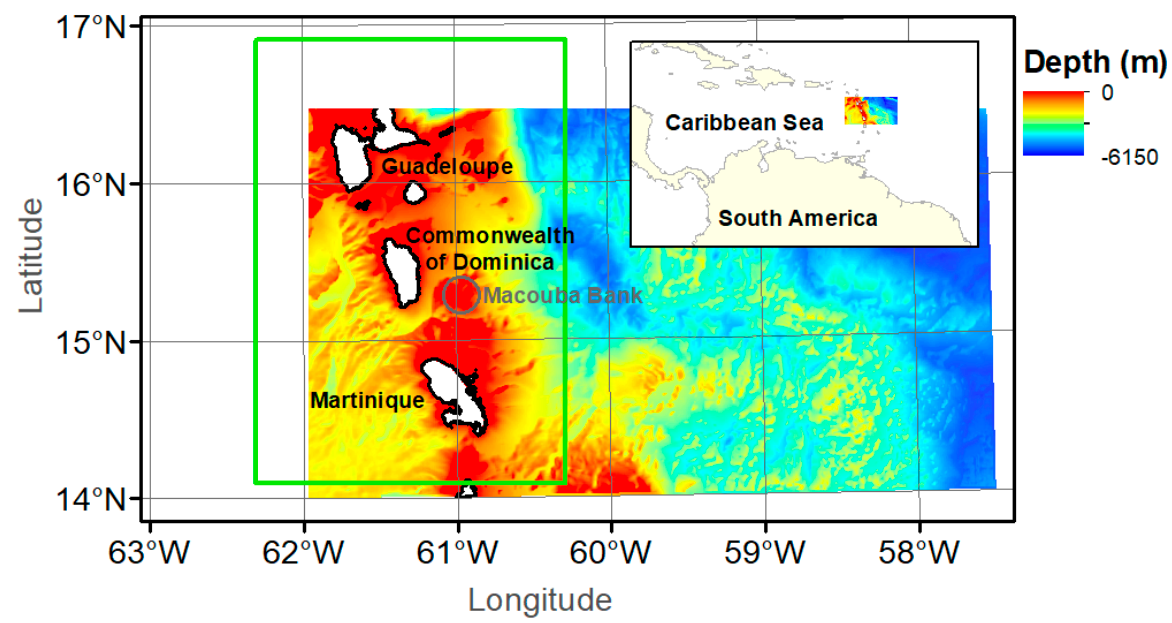
Figure 1. Location of study area. The green outline shows the second, smaller bounding box extent, the grey outline shows the location of Macouba Bank.